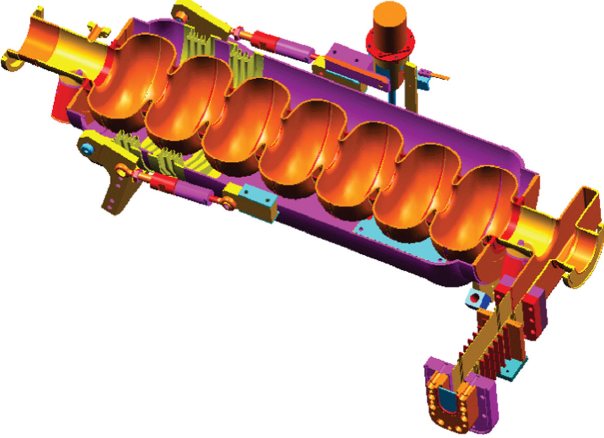
FIG. 25. Cross section of Renascence cavity, couplers, helium vessel, and tuner.